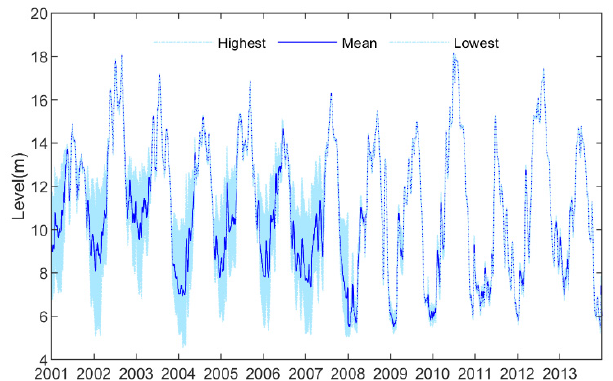
Figure 7. Daily in situ water level observations from the five stations during 2001–2013. The highest, mean and lowest lines indicate the maximum, mean and minimum of the five observations. Because only two observations were available after 2009, the three lines overlap with each other.